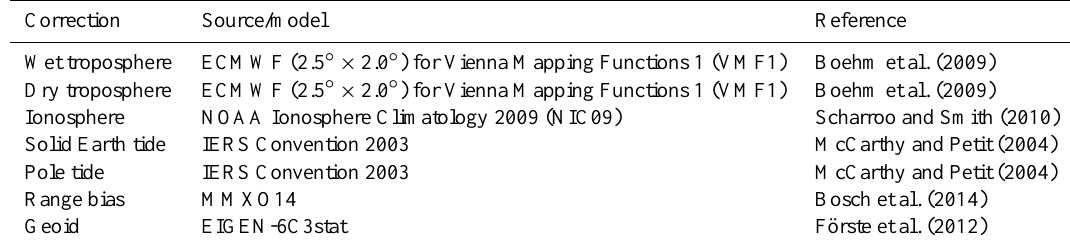
Table 2. List of applied models and geophysical corrections